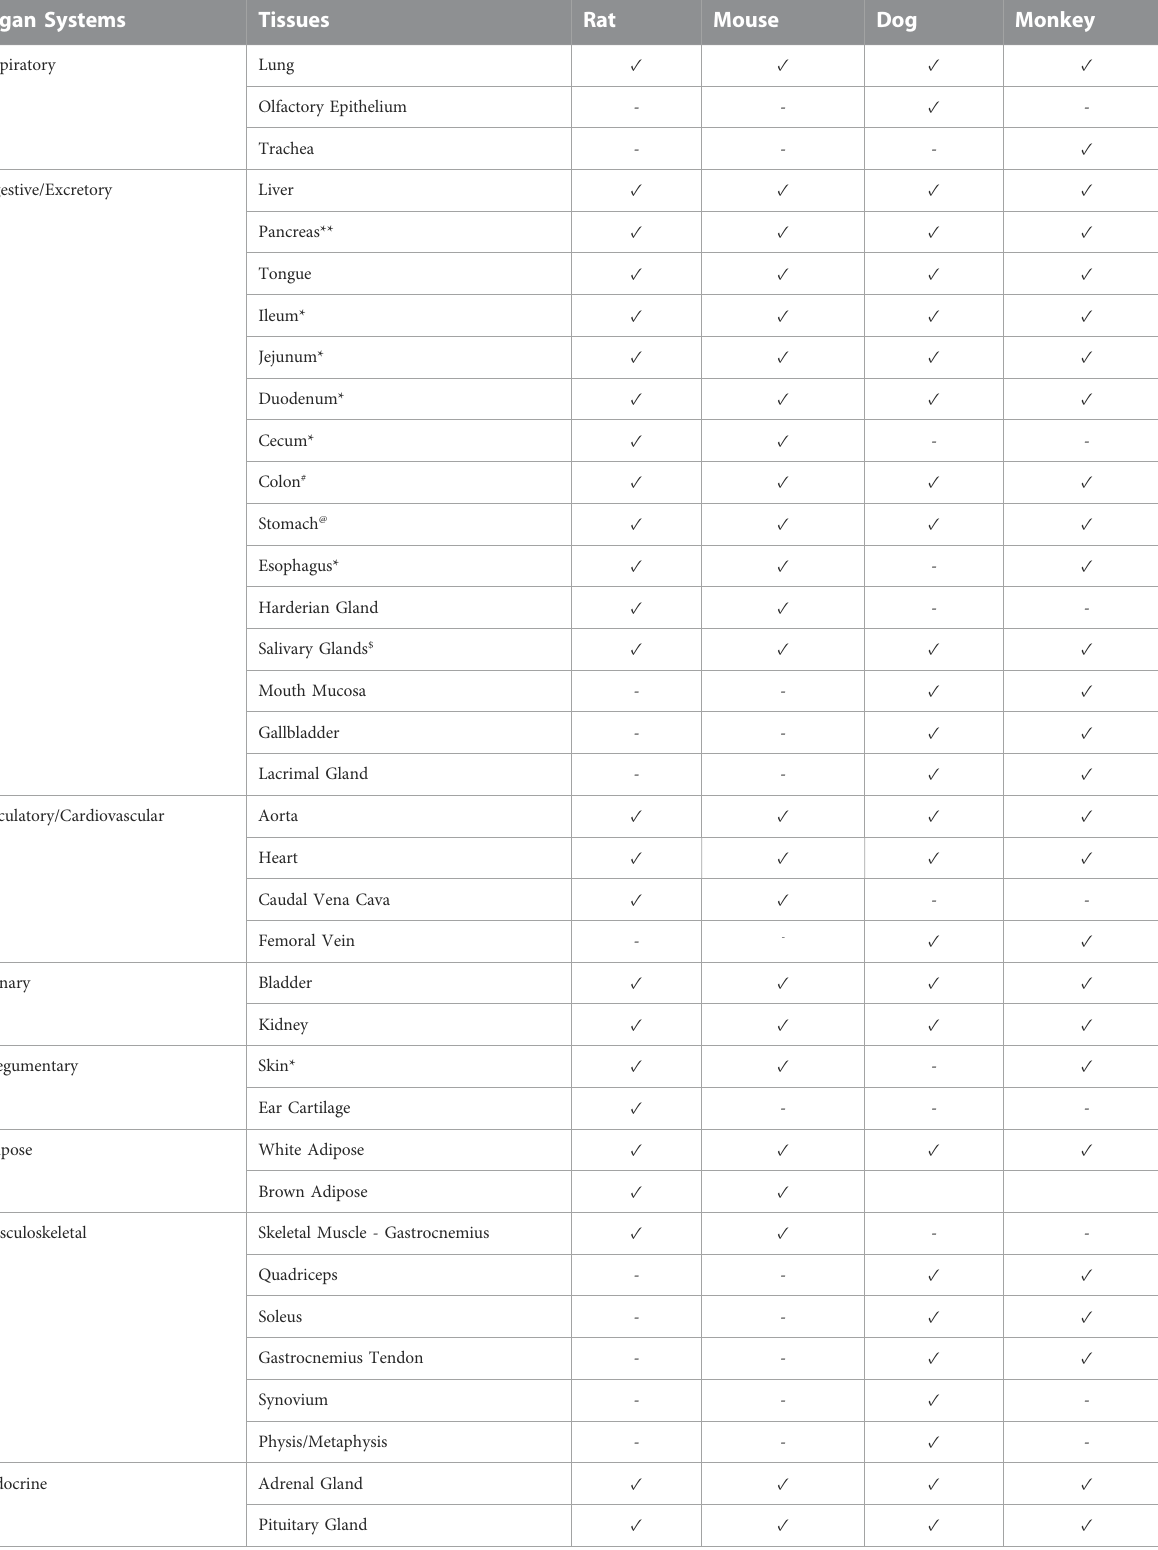
TABLE 1 List of Tissues Collected ( ✓ ) Across Each Species and Respective Classi fi ed Organ Systems. A total of 47 – 57 tissues were collected for each species. After collection, a portion of tissues was transferred to a Whirl-Pak bag and immediately fl ash frozen in liquid nitrogen and stored at − 80 ° C. Organ